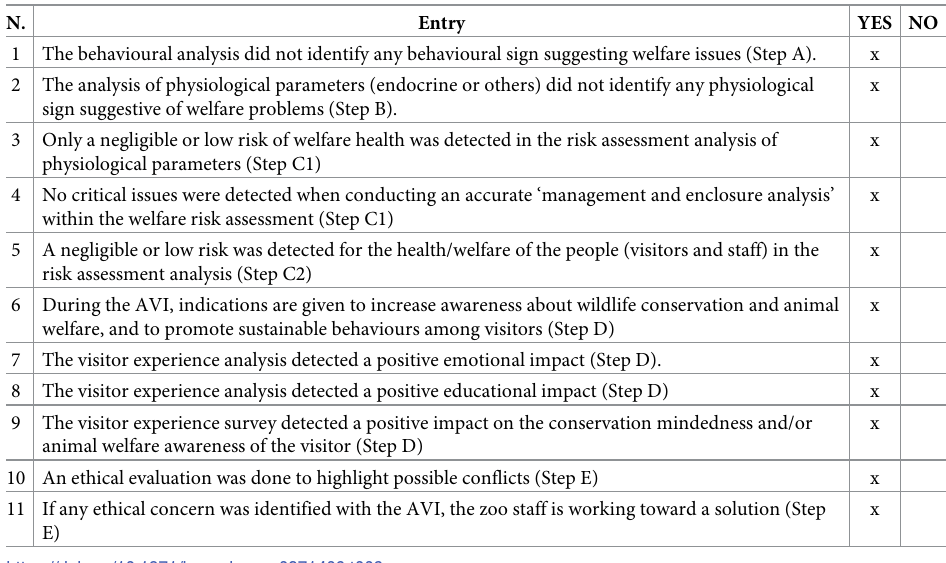
Table 8. Final assessment checklist. Adapted from [24].